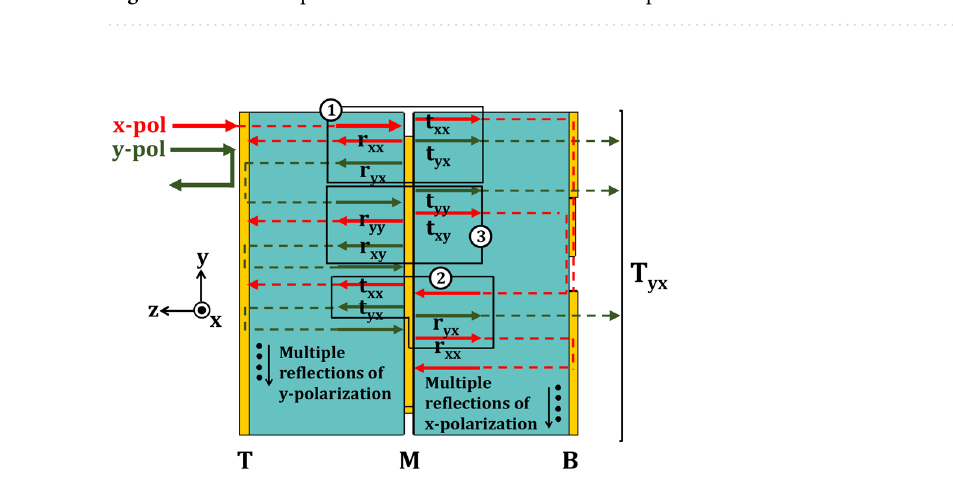
Figure 8. Reflection parameters with identification of three plasmonic resonances.